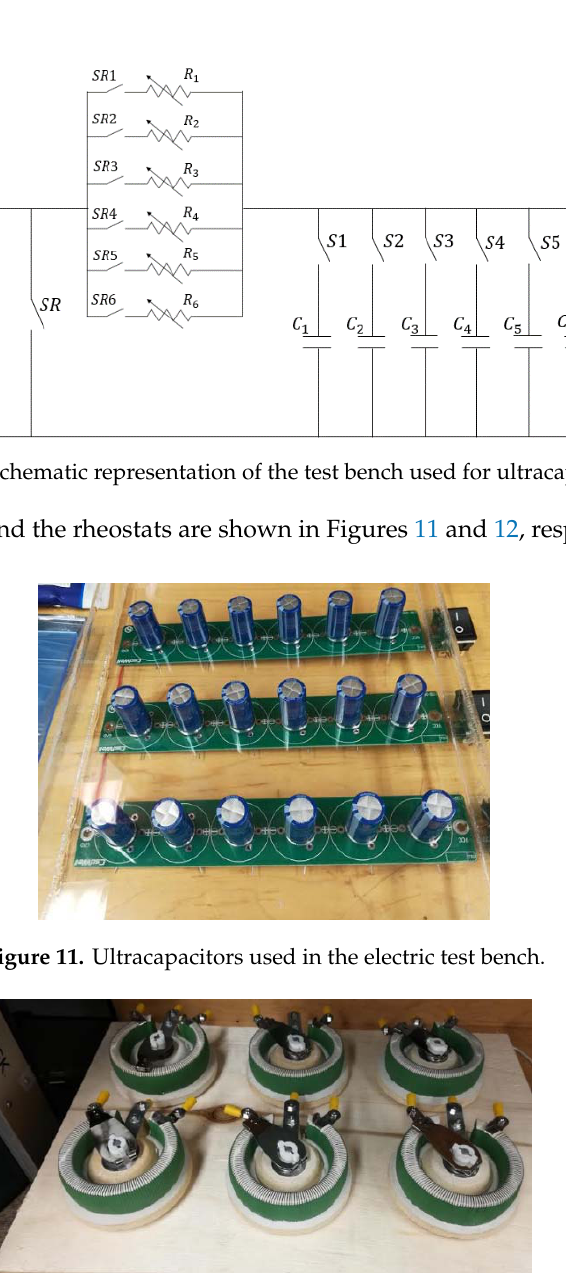
Figure 12. Resistor bank used in the electric test bench.